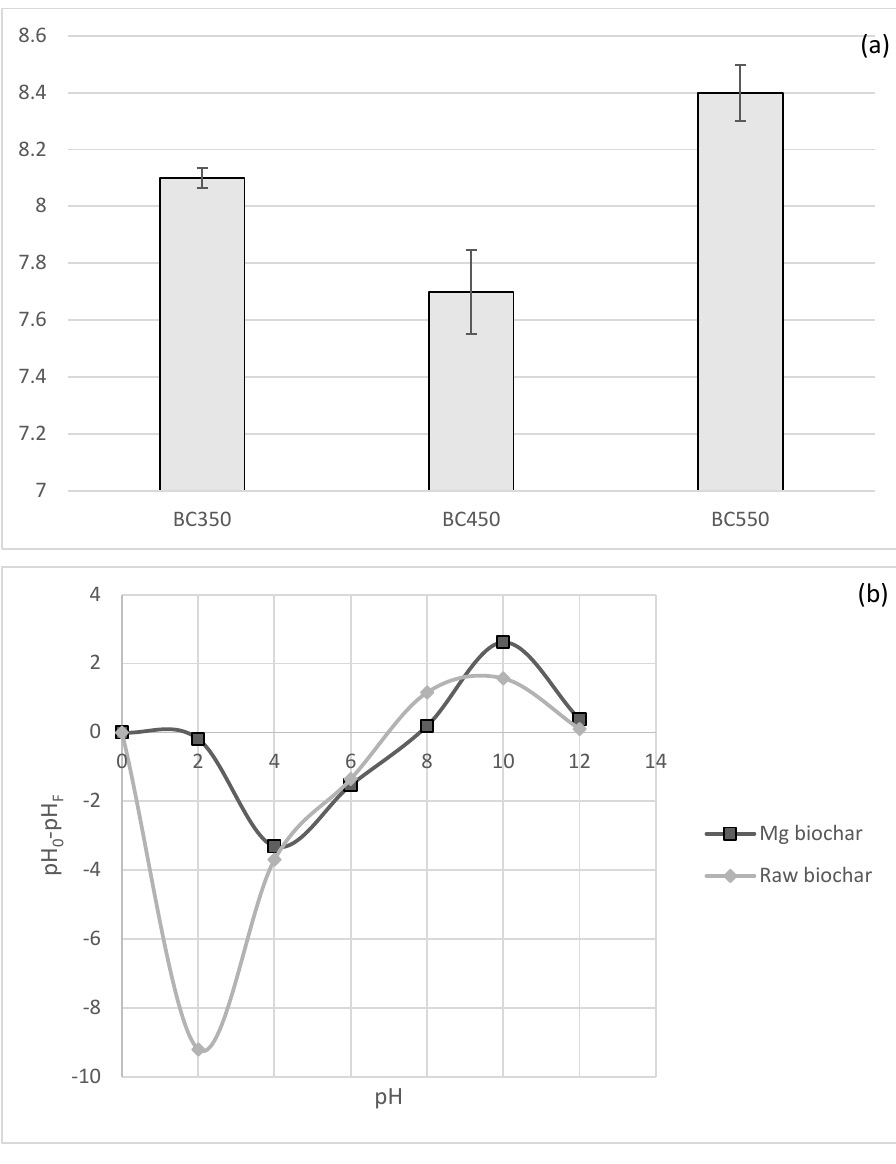
Figure 3. ( a ) pH values of raw biochar obtained from the pyrolysis of hardwood; and ( b ) point of zero charged pH PZC from raw biochar and modified biochar (550 °C).